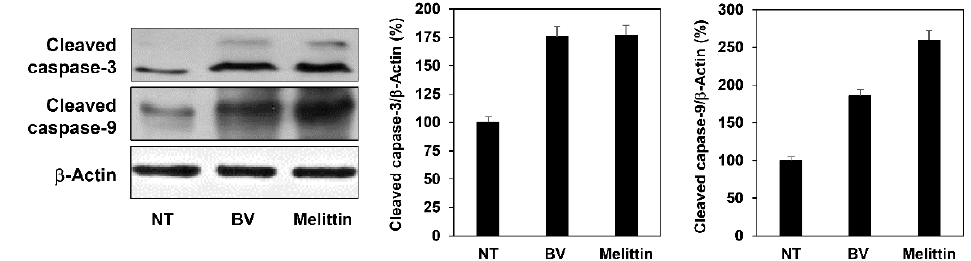
Figure 7. The effect of BV and melittin on the expression of apoptosis regulatory proteins in A375SM melanoma cells. Cells were treated with BV and melittin for 24 h, and the expression levels of cleaved caspase-3 and cleaved caspase-9 were detected by Western blotting. The levels of β-actin were used as an internal control. Each value represents the mean ± SE from three independent experiments.